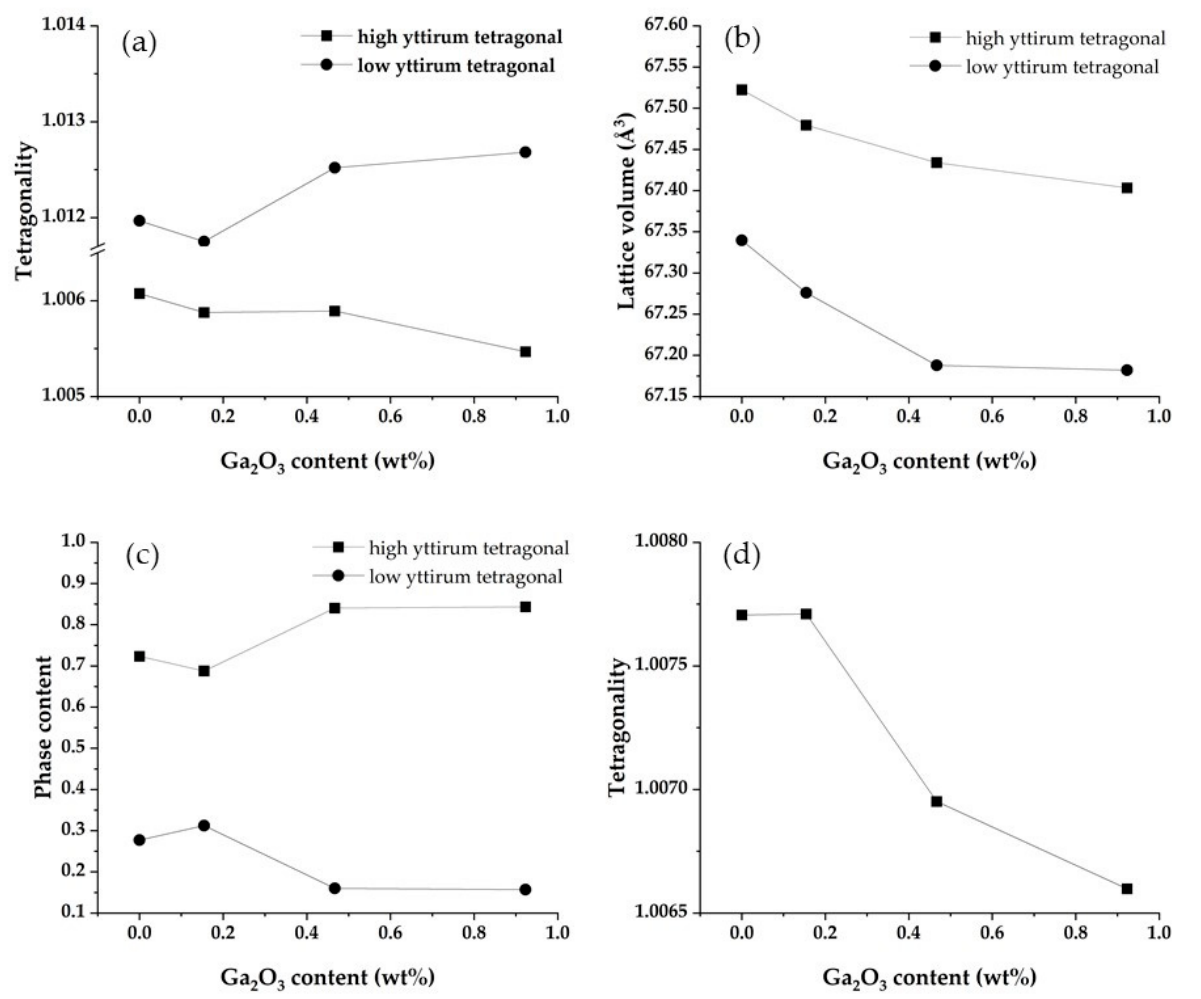
Figure 8. Relationship between ( a ); tetragonality, ( b ); lattice volume, ( c ); phase contents, and ( d ); mean tetragonality as calculated by Equation (4) and Ga 2 O 3 concentration.